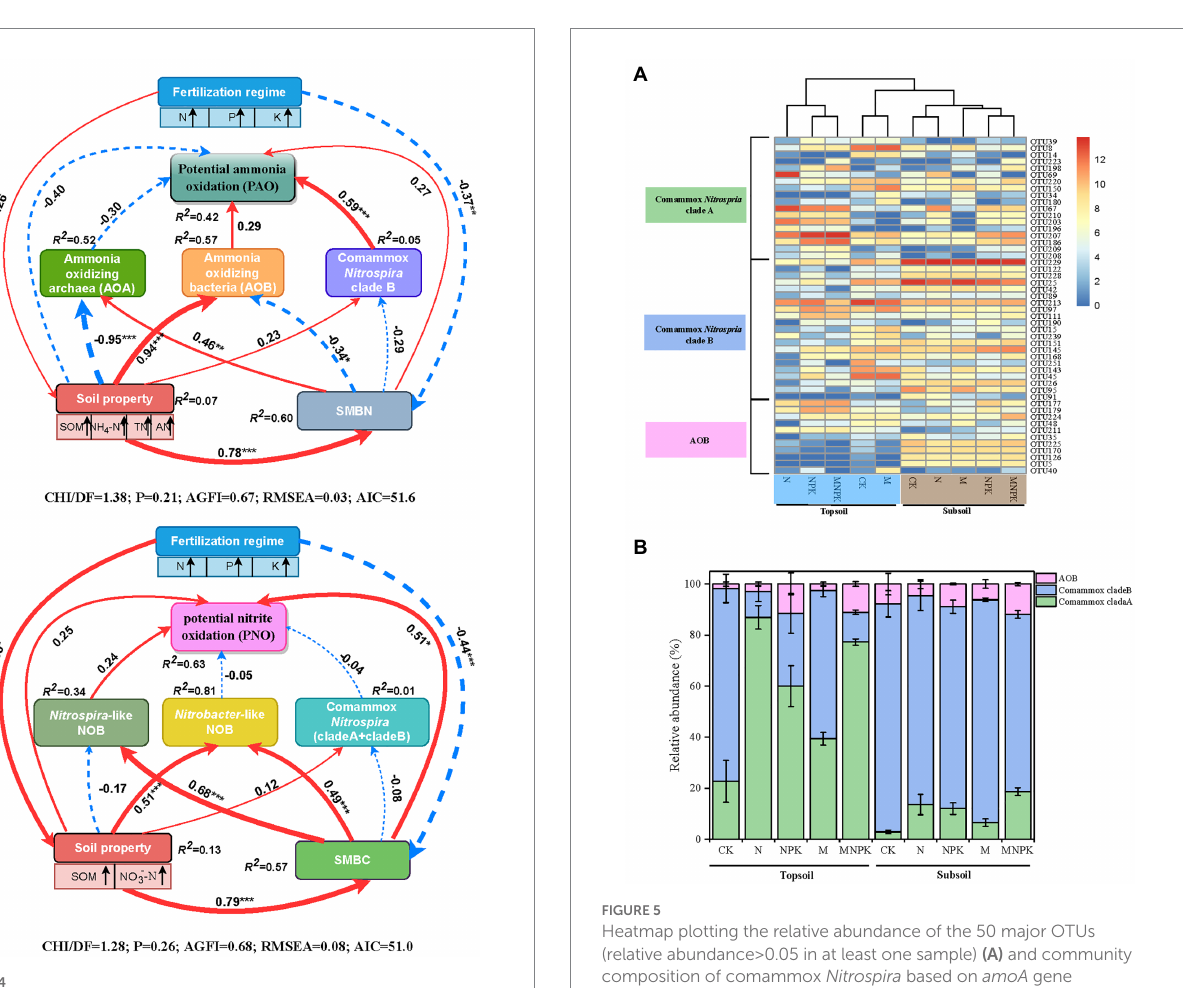
FIGURE 4 Path diagrams demonstrating the potential causal relationships among the fertilization regime, soil properties (SOM, NO 3 − -N, NO 4+ -N, TN and available N), soil microbial biomass (C and N), the abundances of nitrifiers (AOA, AOB, comammox Nitrospira clade A, comammox Nitrospira clade A, Nitrobacter -like NOB and Nitrospira like NOB) and soil PAO (A) or PNO (B) . The width of the arrows in proportional to the strength of the potential causal effects adjacent with path coefficients. The red solid and blue dashed lines indicate the positive and negative relationships between the indicators, respectively. The R 2 demotes the percentage of variance explained by the corresponding indicator in the structural equation modeling. Significant levels are indicated as follows: * p < 0.05, ** p < 0.01, and *** p < 0.001. SOM, soil organic matter; TN, total N; AN, available N; NH 4+ -N, ammonium N; NO 3 − -N, nitrate N; SMBC, soil microbial biomass C; SMBN, soil microbial N.